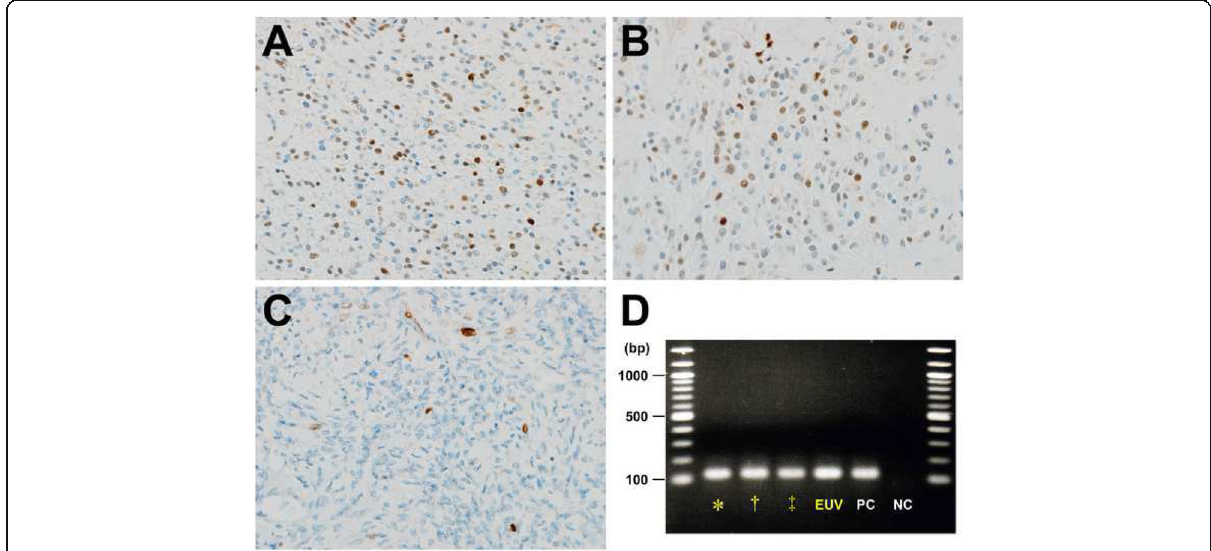
Fig. 3 Cyclin D1 immunostains of the endometrial stromal sarcoma harboring the JAZF1 – SUZ12 fusion gene. a and b 50% nuclear staining of tumor cells for Cyclin D1 in the right-anterior ( a ) and right-posterior ( b ) components (IHC, × 200). c Less than 1% of tumor cells positive for Cyclin D1 in the fundal component (IHC, × 200). d Reverse transcriptase-polymerase chain reaction demonstrating the JAZF1 – SUZ12 chimeric transcripts in the right-anterior (*), right-posterior ( † ), and the fundal ( ‡ ) tumors and the tumor extension into the extrauterine vein (EUV). PC,